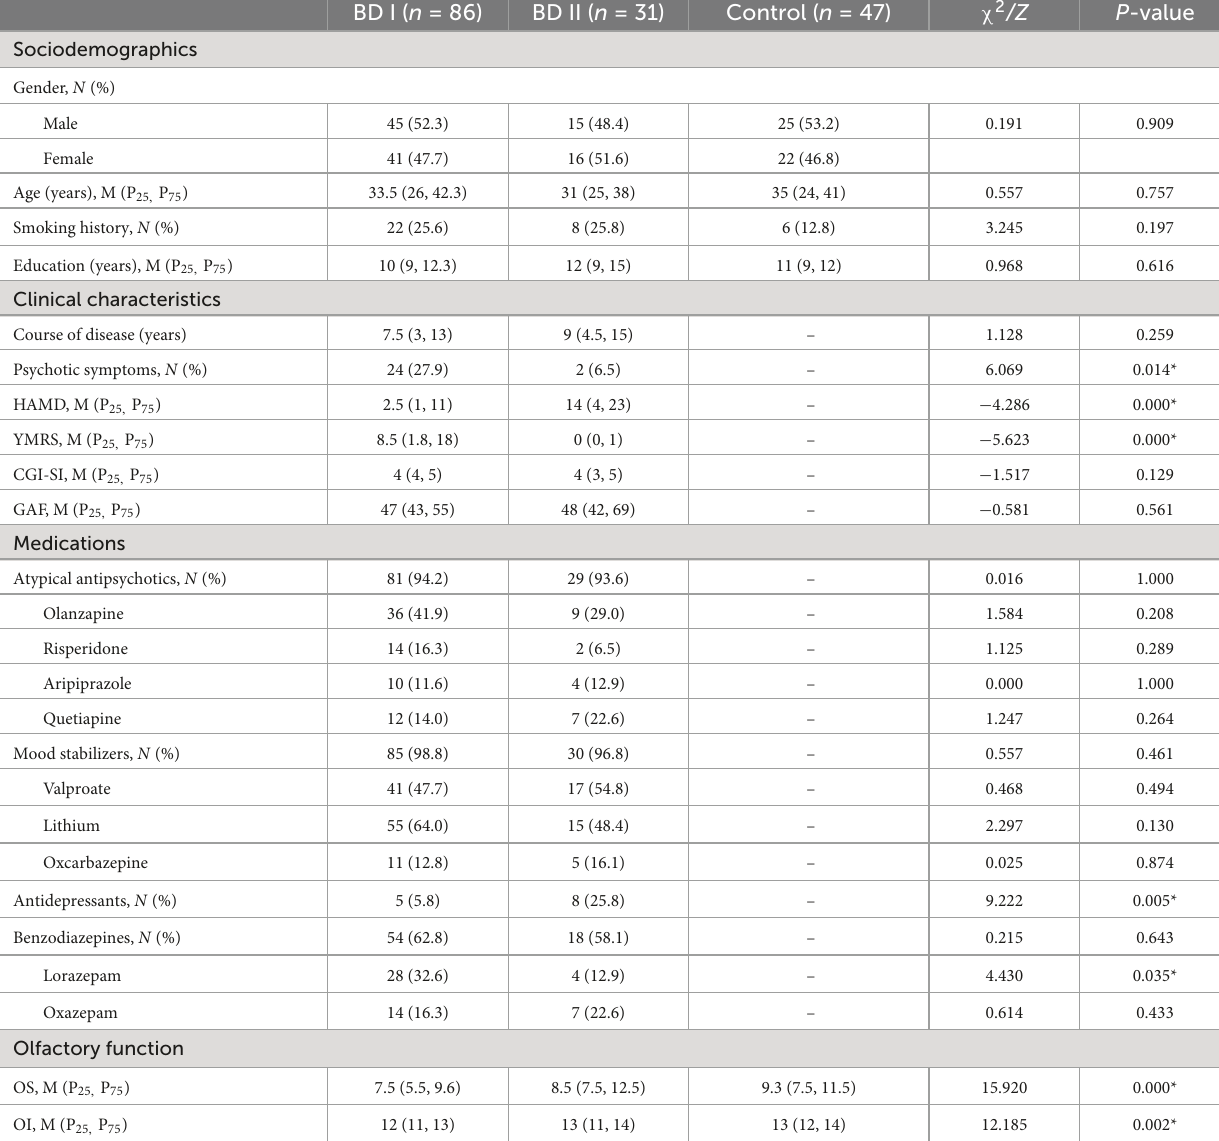
TABLE 2 Sociodemographic and clinical characteristics of the BD I, BD II, and control groups. BD I ( n = 86) BD II ( n =